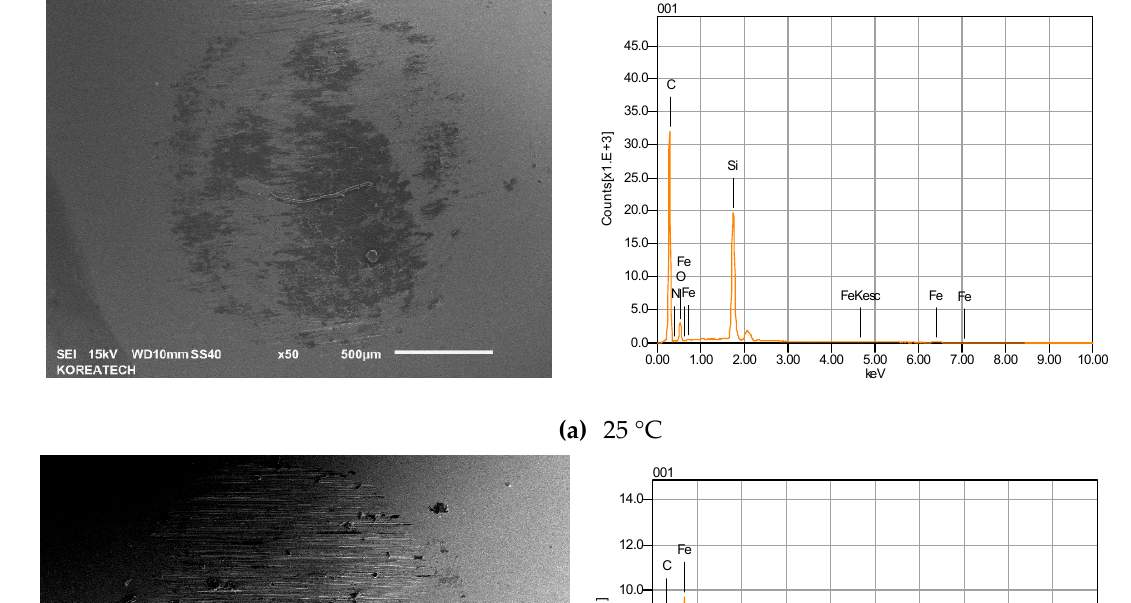
9 of 13 Figure 10. Wear rate of the C/C-SiC composite slid against AISI52100 steel at temperatures of 25, 100, and 200 °C. Figure 11 presents the wear scar formed on the counter ball surfaces and its chemical composition when the balls slid against the disc specimens at temperatures of 25, 100, and 200 °C. No significant difference in wear scar was found for the balls tested at temperatures of 25 and 100 °C. However, the counter ball surface tested at 200 °C demonstrated a much larger wear scar diameter and rougher surface with a high amount of Fe and Cr elements, which were transferred from the counter surface, than the specimen tested at a temperature of 25 °C. This means that the contact area of the specimen tested at a temperature of 25 °C with the corresponding ball was smaller than that of the specimens tested at a temperatures of 200 °C with the corresponding ball. Figure 12 shows the wear volume of the balls. The wear volume was quantified using the equation presented above. It is obvious that the ball tested at a temperature of 25 °C exhibited a higher resistance to wear than the specimens tested at a temperature of 200 °C. A similar result was reported in [20]. The presence of SiC in a C/C composite increases the friction coefficient during braking, but the wear resistance can also be mitigated because of the abrasive character of SiC. With an increasing temperature, the friction coefficient and wear rate deteriorated due to the flexion by debonding of SiC grains where the C fiber loosened. Braking increases the temperature of the disc and the pads, and the friction coefficient. The wear rate also increases simultaneously. In addition, the friction coefficient of a C/C-SiC composite